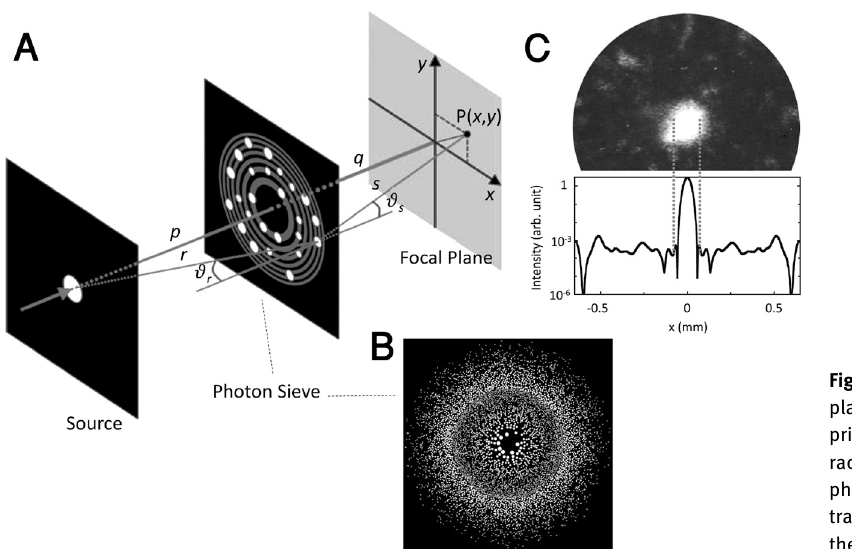
Figure 9: Photon sieve structure for focusing planar light radiation. (A) The design principle for achieving constructive radiation at the focal plane (B) A fabricated photon sieve structure comprising 5646 transmissive pinholes (C) The intensity at the focal plane